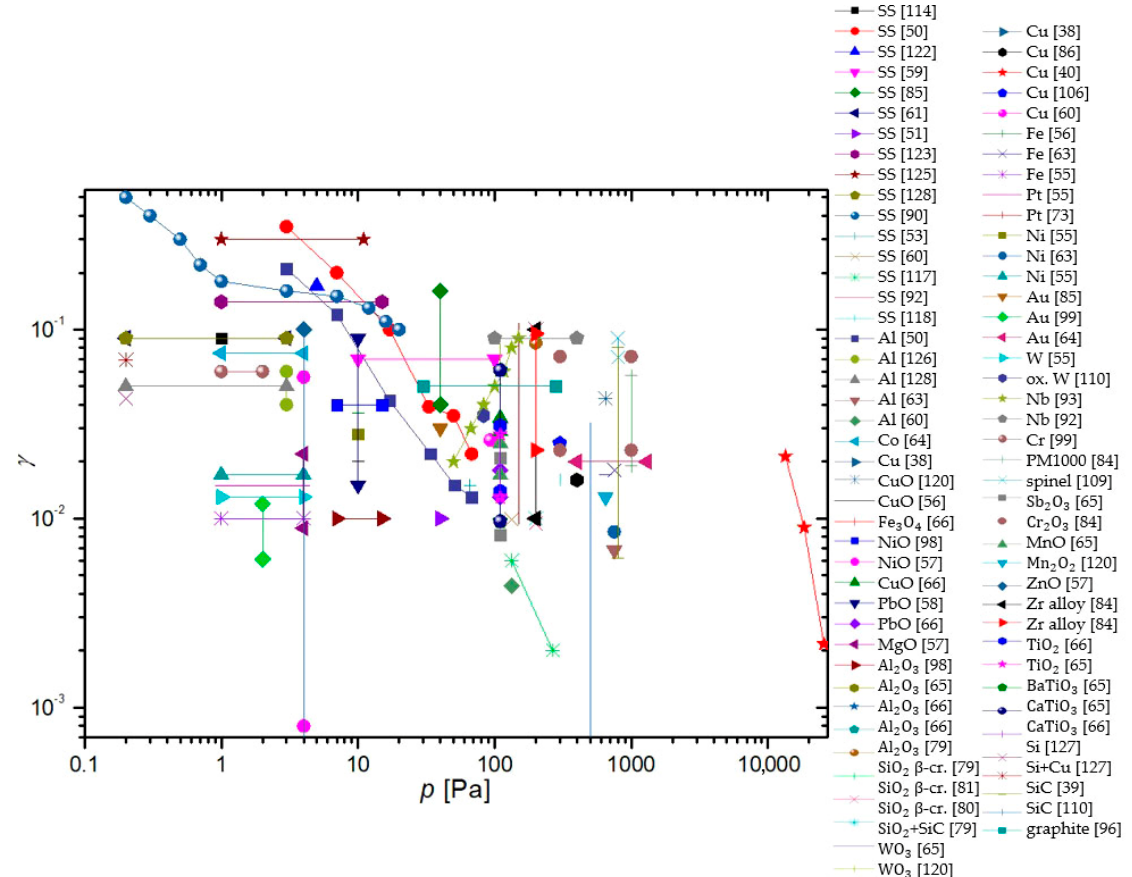
Figure 20. Recombination coefficient ( γ ) of neutral oxygen atoms versus pressure ( 𝑝 ) for various semi-catalytic surfaces.